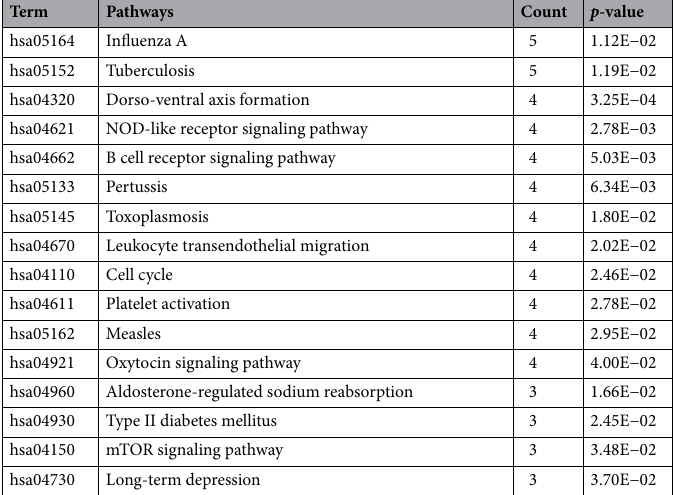
Table 3. KEGG analysis of candidate targets of fucosterol for NSCLC.